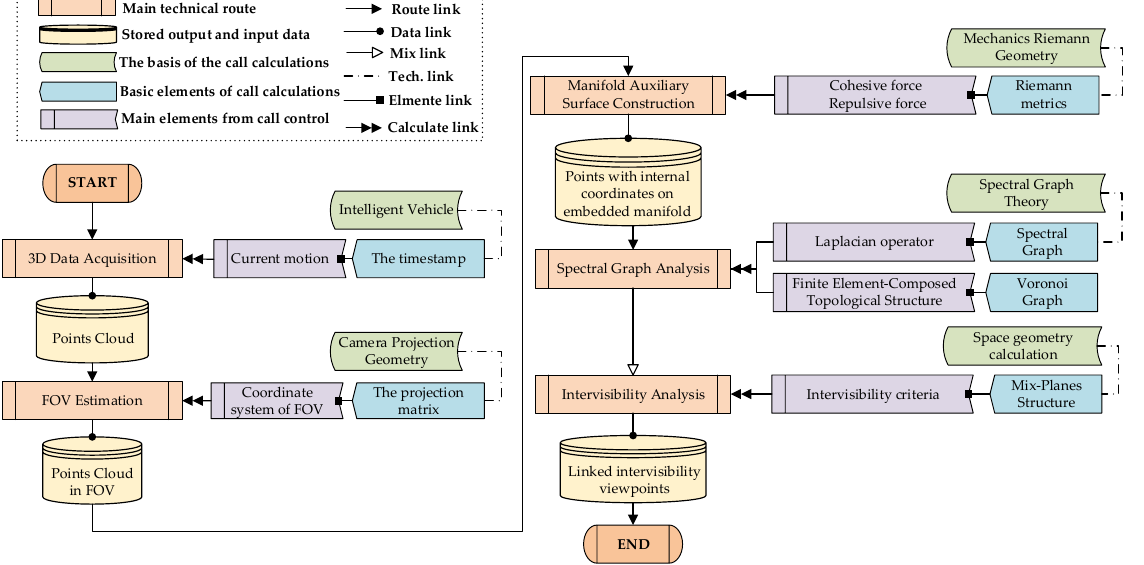
Figure 1. The roadmap and technical points of this method.